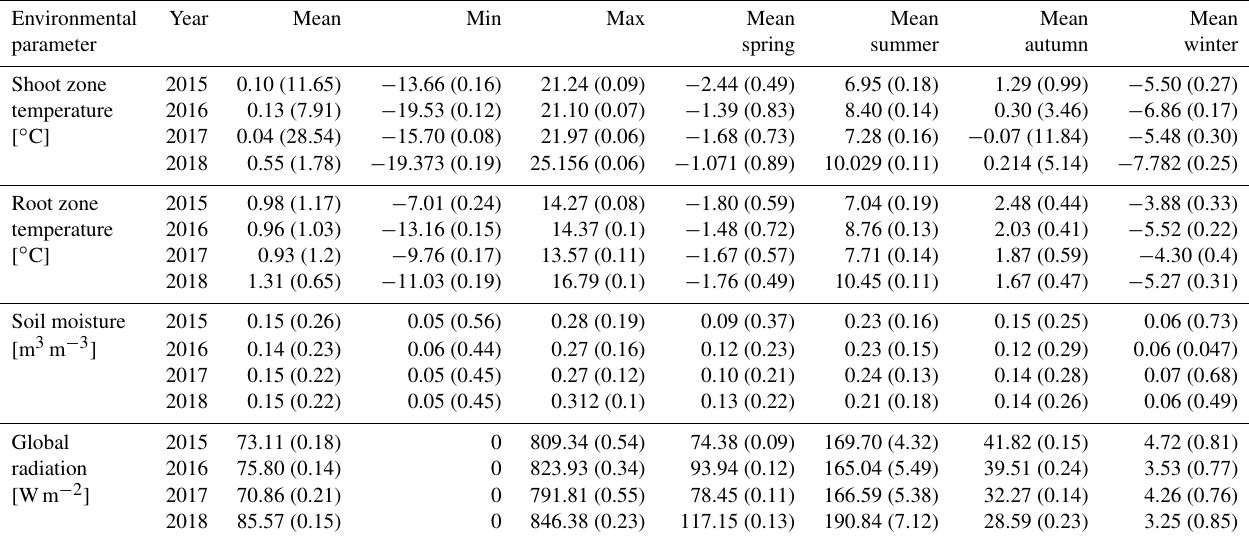
Table 4. Summary of collected environmental data: annual mean, minimum, and maximum values as well as mean values for each meteoro- logical season. Numbers in parentheses represent site variability (coefficient of variation,